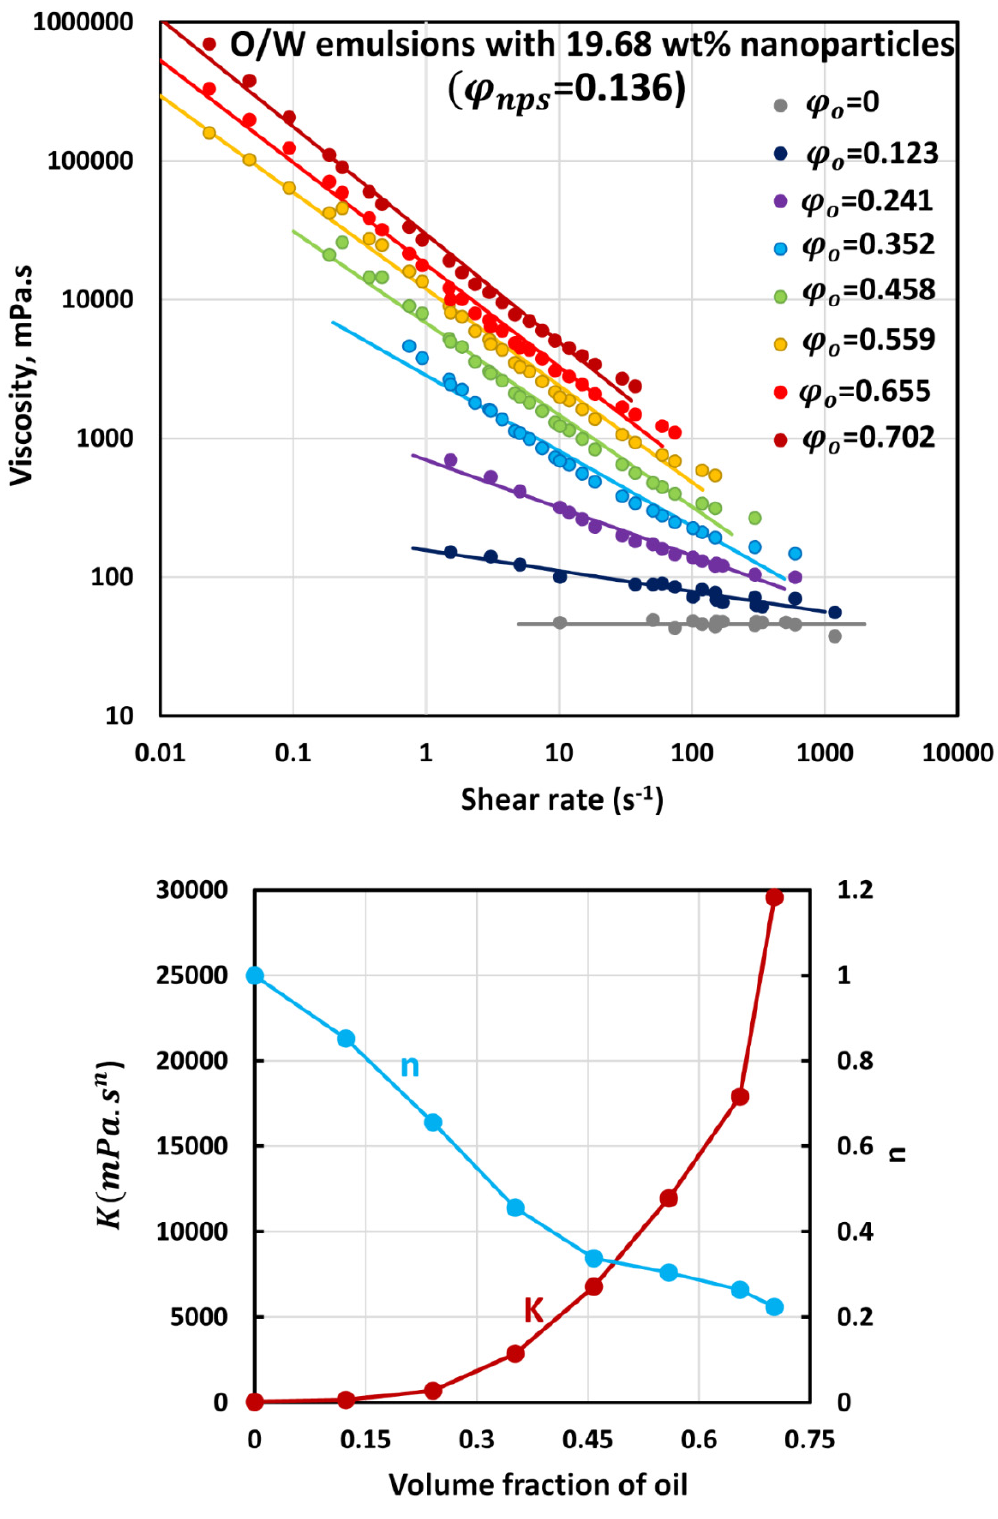
Figure 9. Flow behavior of O/W emulsions thickened with starch nanoparticles at nanoparticle concentration of 19.68 wt% ( ϕ nps = 0.136).